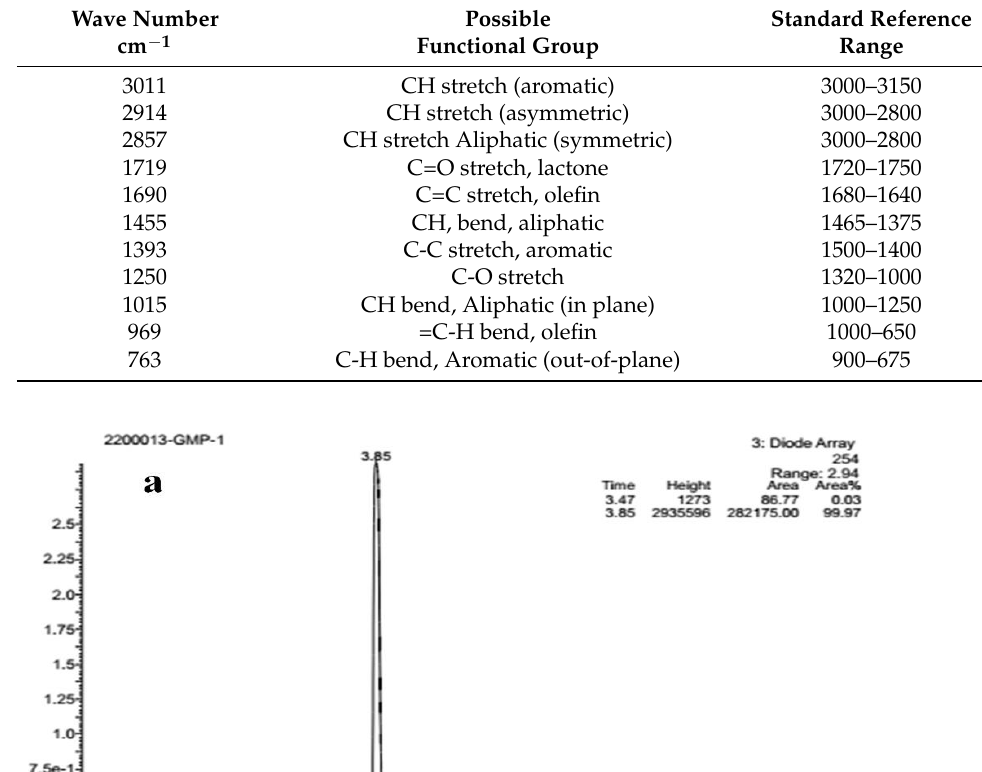
Table 1. FTIR spectrum of isolated compound using hexane extract of G. wightii .